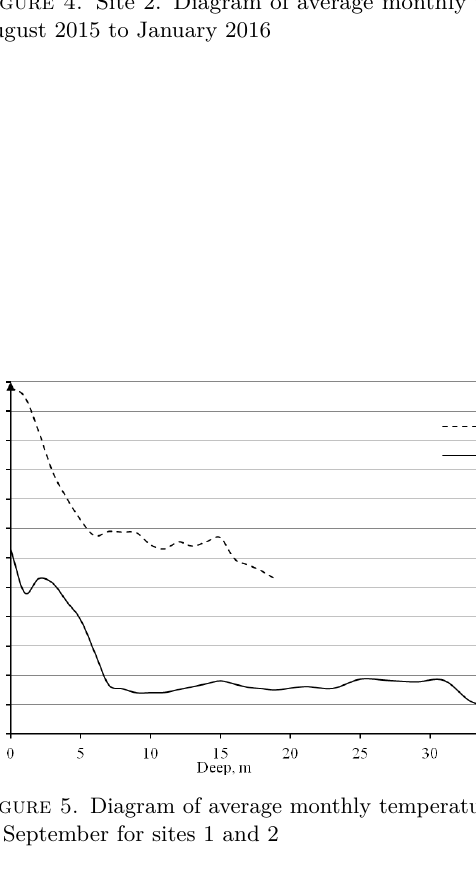
Figure 4. Site 2. Diagram of average monthly temperatures of soil mass according the monitoring results from